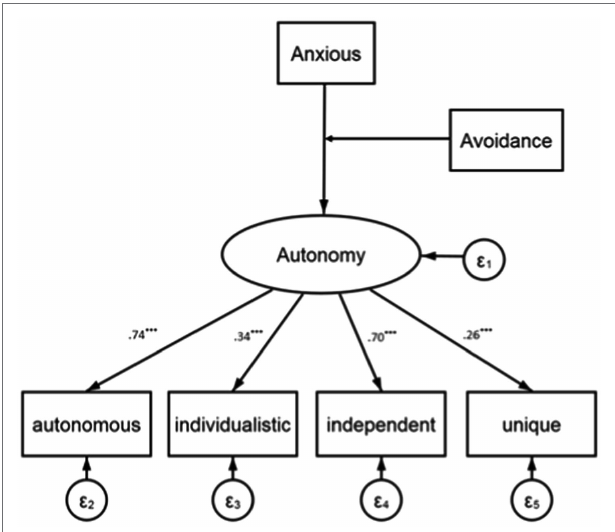
FIGURE 1 | Maximum-likelihood parameter estimates for the hypothesized model without controls (Study 1). * p < 0.05, ** p < 0.01, *** p < 0.001; n =